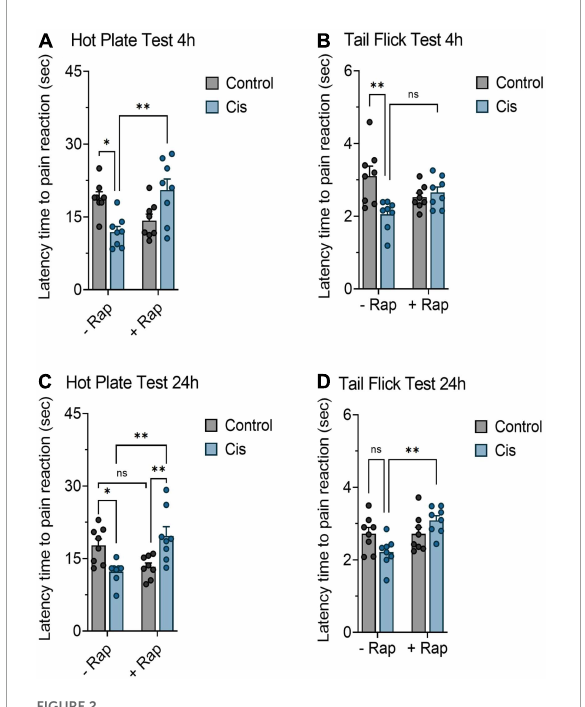
FIGURE2 Effect of rapamycin on thermal hypersensitivity induced by acute exposure to cisplatin. Balb/c mice were treated with a single dose cisplatin 10 mg/kg (i.p.) with or without rapamycin 3 mg/kg (s.c.) for 24 h. (A,C) Impact of rapamycin on cisplatin using hot plate test 4 and 24 h post-treatment, respectively. (B,D) Impact of rapamycin on cisplatin using tail flick test 4 and 24 h post-treatment, respectively. ∗ p < 0.05, ∗∗ p < 0.01, ∗∗∗ p < 0.001, and ∗∗∗∗ p < 0.0001 indicates statistical significance between treatment groups (two-way ANOVA followed by Tukey’s post-hoc test; n = 8